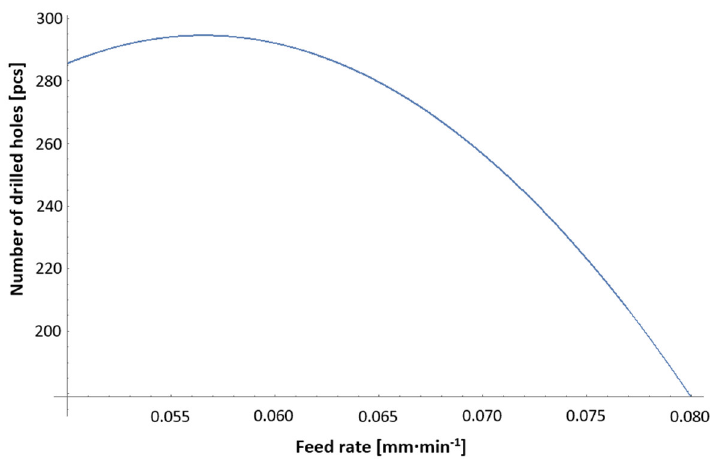
Figure 19. Course of dependence of the number of holes drilled up to the moment of tool damage in the range of the feed rates used.